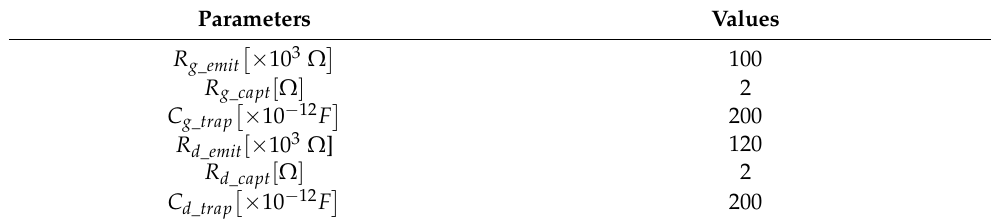
Table 2. Extracted values of coefficients of parameters varying with trap voltages.